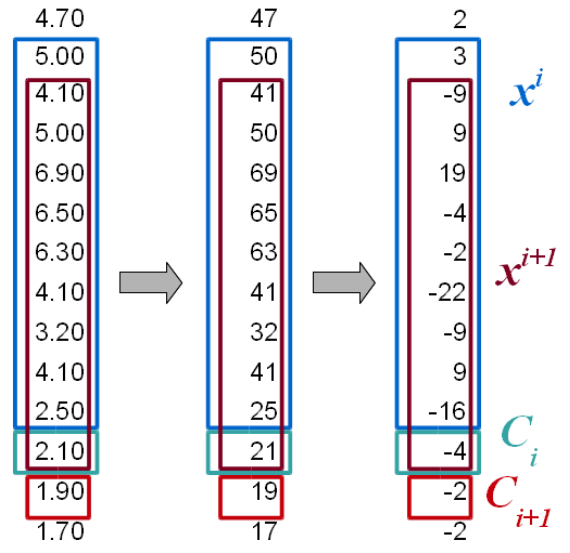
Fig. 2. How patterns are built from the samples, when n =